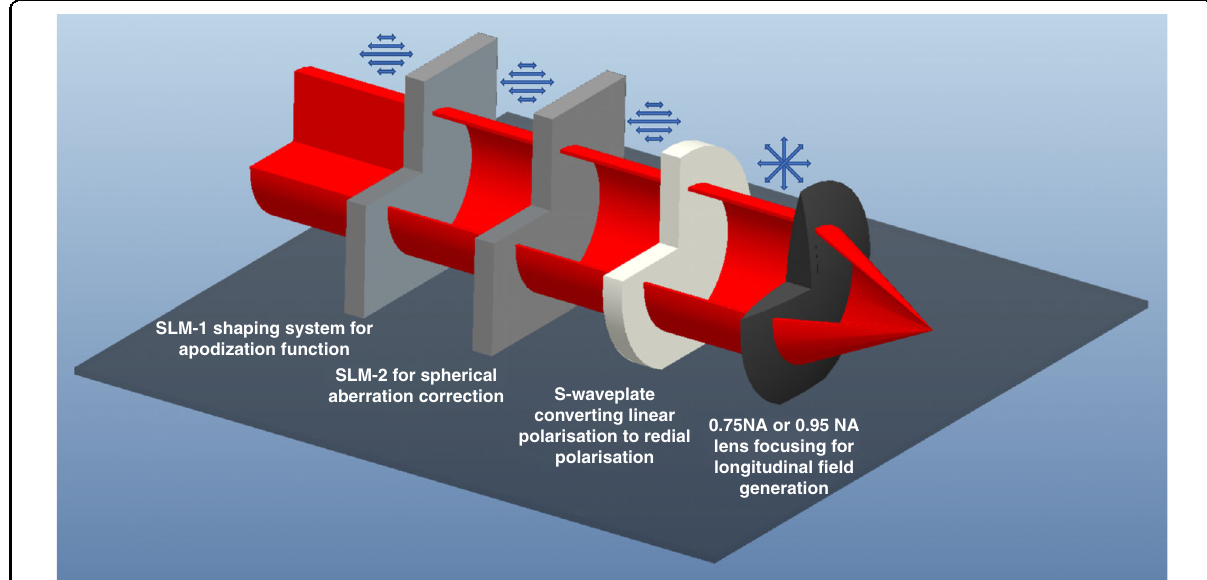
Fig. 8 A 3D diagram showing the principle of longitudinal fi eld generation